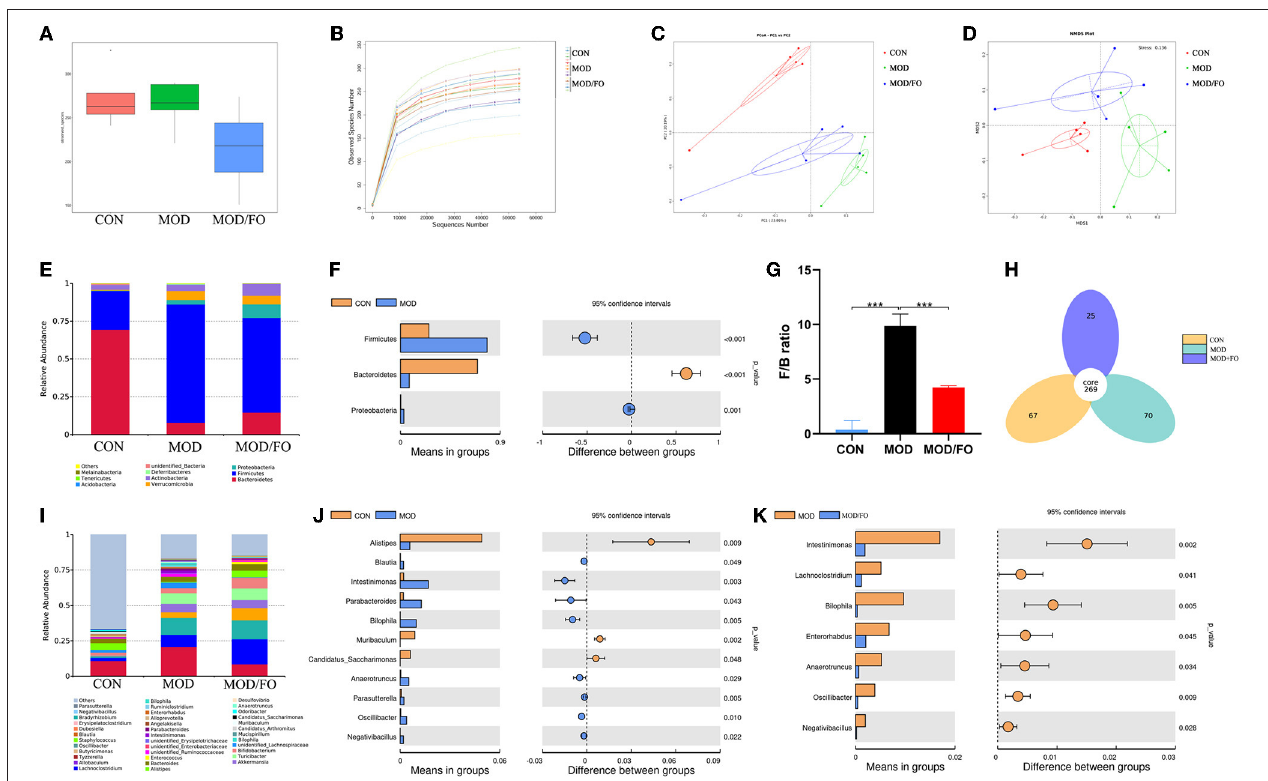
FIGURE 3 | Gut microbial community in fecal samples of different groups. (A) Observed-species index. (B) Rarefaction Curve. (C) PCoA analysis. (D) NDMS analysis. (E–G) The phylum level. (H) Venn diagram. (I–K) The genus level. Values are given as mean ± SEM. *** P <